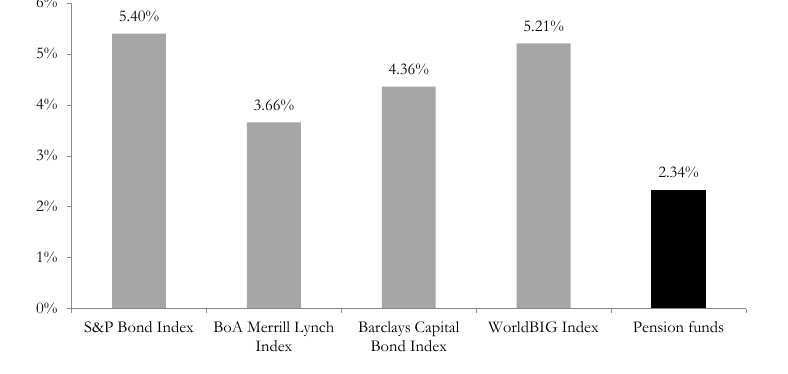
Fig. 2 – Average annual yield of the selected bond indices and the aggregate value of the pension funds from 2005 to 2015. Source: The Organisation for Economic Co-operation and Development